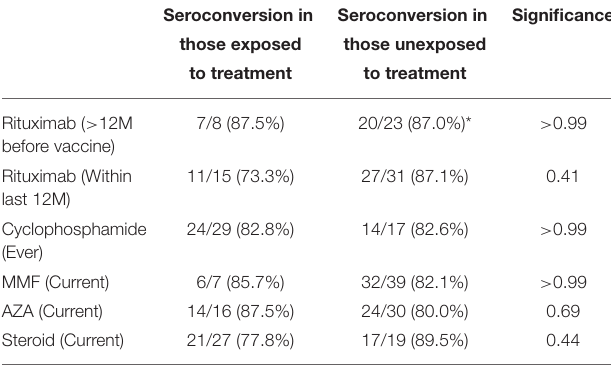
* Figure excludes those who received Rituximab within the last 12